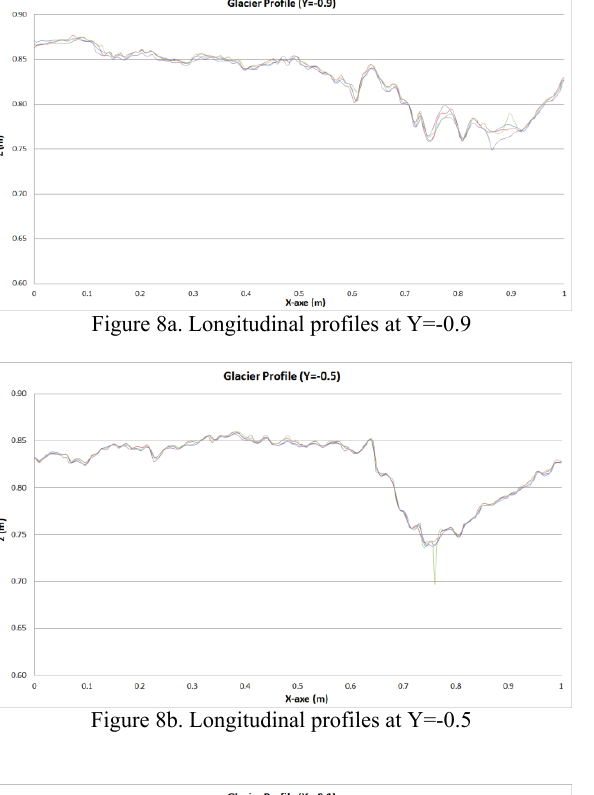
Figure 8b. Longitudinal profiles at Y=-0.5